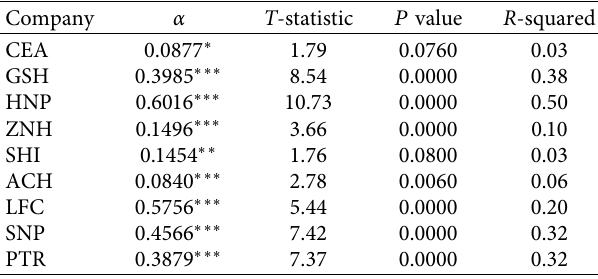
Table 2: Validation with dual-listed companies.